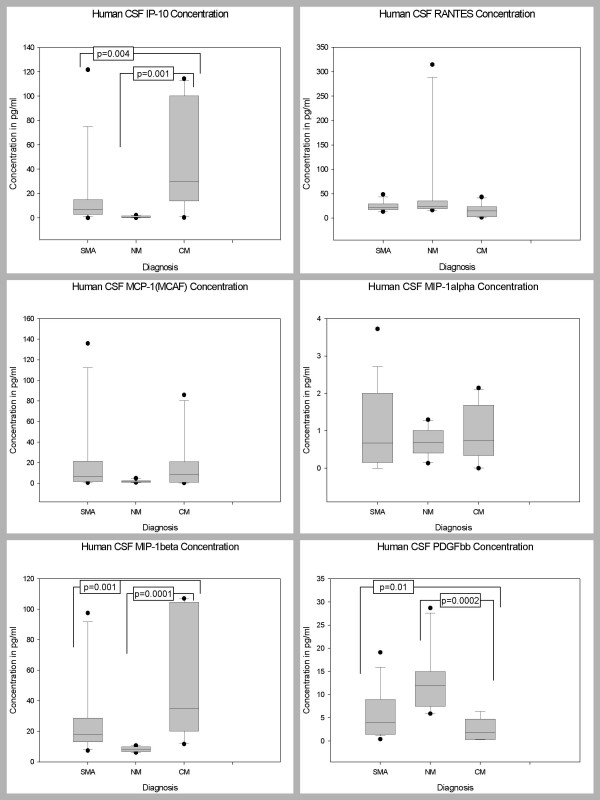
Postmortem CSF biomarker levels of IP-10, RANTES, MCP-1, MIP-1α, MIP-1β, and PDGFbb in children dying with CM, SMA, NM causes. CM, cerebral malaria; SMA, severe malarial anemia; NM, non-malaria. Box plots representing medians with 25th and 75th percentiles, bars for 10th and 90th percentiles, and points for outliers of biomarker concentrations. Only statistically significant P values after Bonferroni adjustment for the other biomarkers are shown.